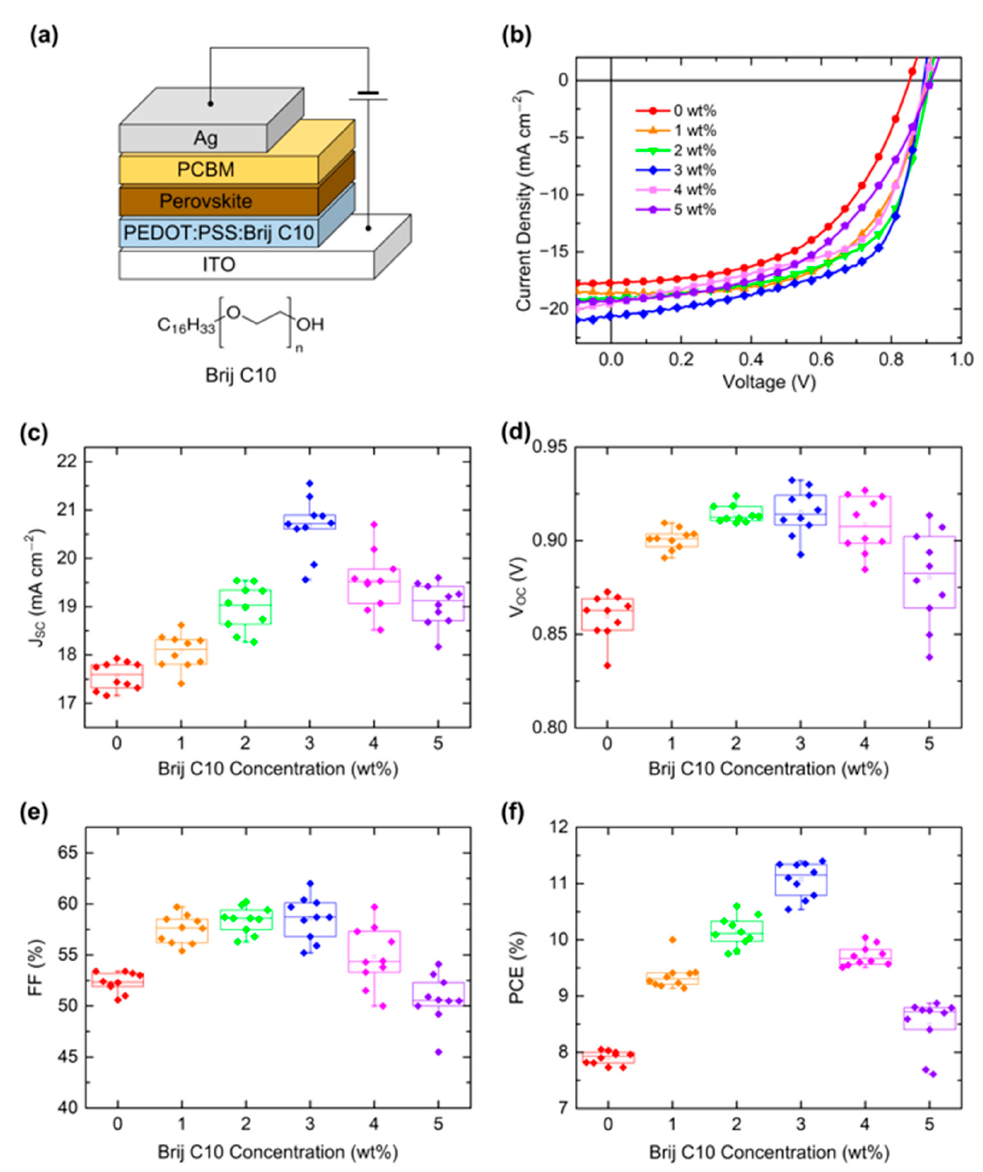
Figure 1. ( a ) Device structure of PSCs and chemical structure of Brij C10. ( b ) J–V characteristics of PSCs with Brij C10-mixed PEDOT:PSS HTL under AM 1.5G 1 sun illumination. Box plots of ( c ) J SC , ( d ) V OC , ( e ) FF, and ( f ) PCE of PSCs. The data were obtained from 10 devices.